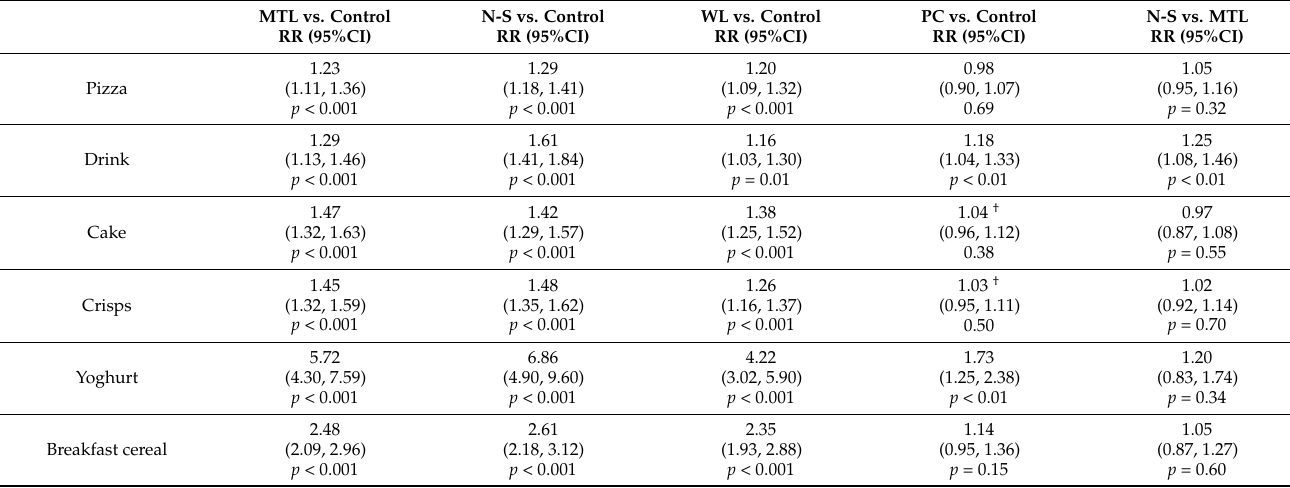
Table 3. Multilevel log-binomial regression results—follow-up (FOPL group) correct (yes/no) and adjusted for baseline rank compared to control (also adjusted for design effects and covariates as